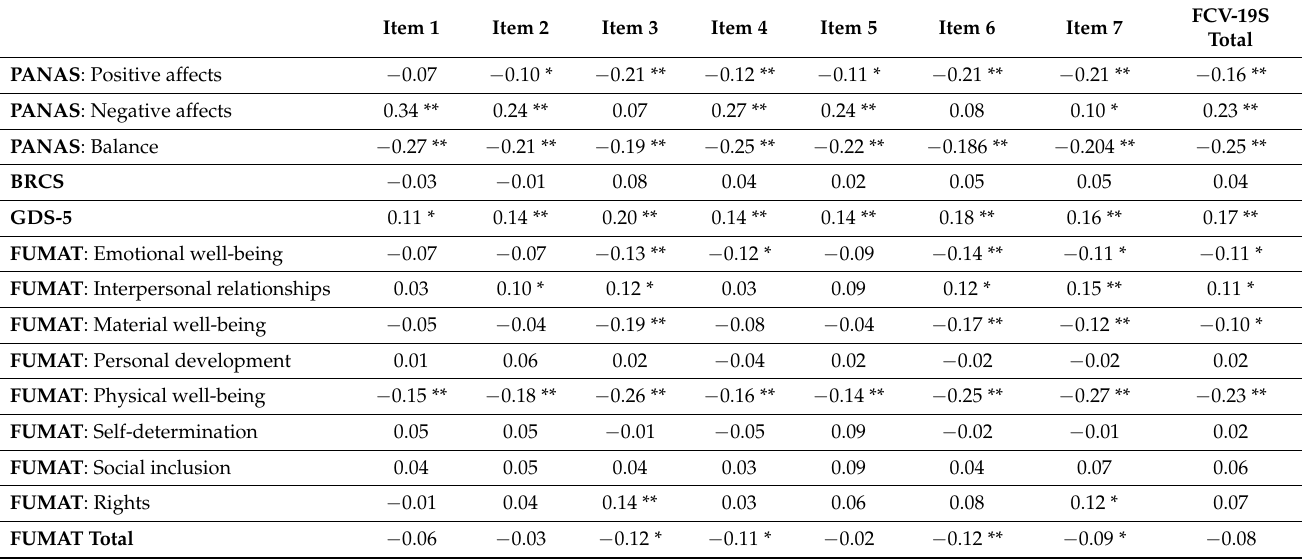
Table 3. Convergent validity of the FCV-19S with related